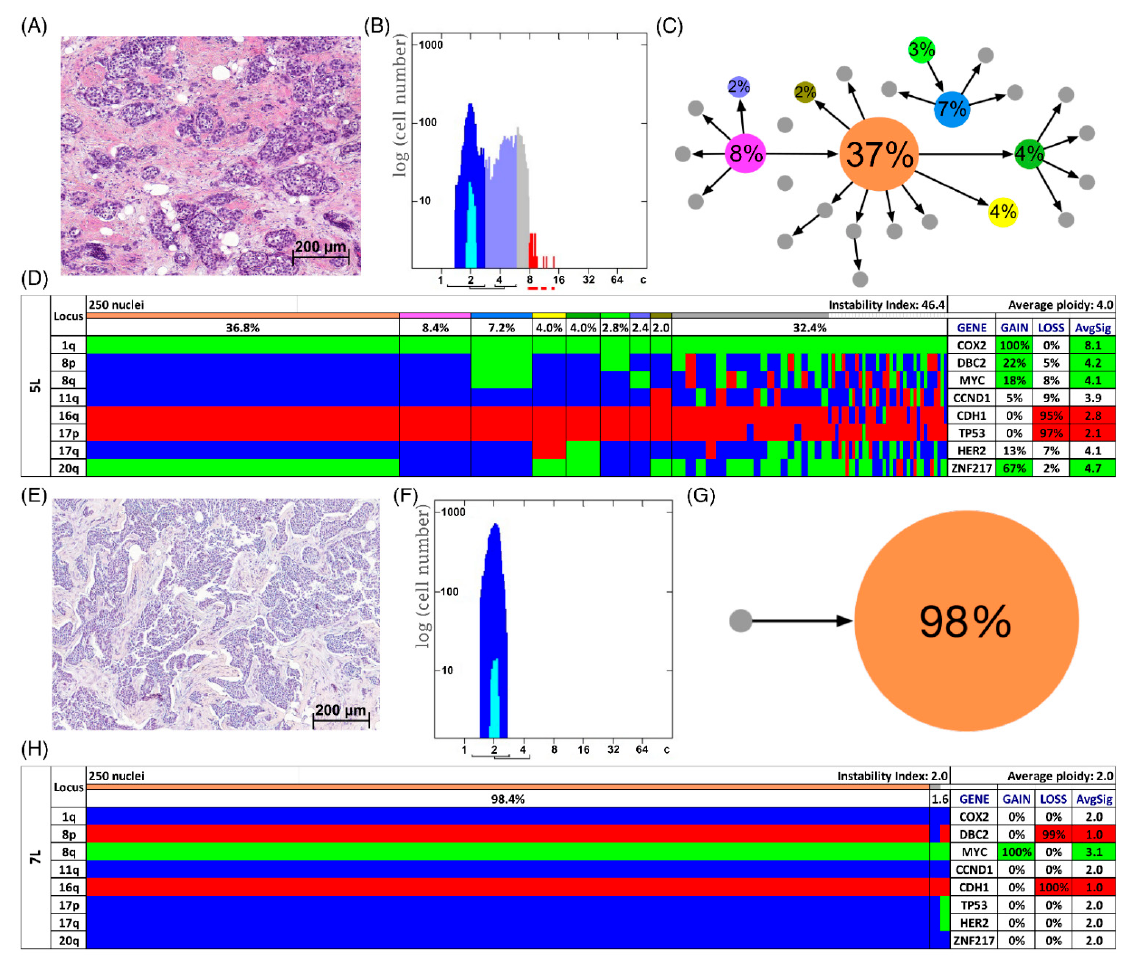
Figure 3. Patients with long survival. Histology ( A , E ), image cytometry ( B , F ), imbalance clone plots ( C , G ) and miFISH results ( D , H ) for the cases 5L ( A – D ) and 7L ( E – H ). ( A , E ) Sections of the respective breast cancer samples showing the histomorphology based on H&E staining. ( B , F ) DNA histograms showing the quantitative measurements of the nuclear DNA content assessed by image cytometry using Feulgen-stained cytospins. The DNA measurements revealed aneuploidy in case 5L and diploidy in case 7L. For quantitative measurement of the DNA content the sample was screened for several diploid nuclei (granulocytes, lymphocytes) to set the 2c value indicating a diploid DNA content. The quantitative measurements of the nuclear DNA content (x axis) of the tumor cells given in ‘c’ units were then calculated accordingly [18]. The y axis represents the total cell count. In case 5L 4759 and in case 7L 11,792 nuclei were analyzed. ( C , G ) Imbalance clone plots visualizing the clonal composition of the analyzed breast cancer section and their putative evolutionary trajectory. The area of the circles correlates with the occurrence of a cell-clone with a specific gain-and-loss pattern within the tumor cell population. Clones derived by a single gain or loss change are connected by arrows. The arrows indicate the clonal evolution according to gain-and-loss patterns in the color charts ( D , H ) starting from the clone with the fewest gains and losses. Thus, unconnected clones must differ in more than one gain or loss in their gain-and-loss pattern. Color coding allows assignment of the individual clones to the corresponding clones in the color charts in D and H. ( D , H ) Color chart of miFISH analysis with 8 gene-specific probes. Copy number counts for each nucleus are displayed as gains (green), losses (red) and neutral (blue). Markers are plotted vertically with the ‘Locus’ column depicting the specific chromosome arm for each probe on the left of the plot, and the corresponding gene name on the right. Nuclei are plotted horizontally by pattern frequency. Each vertical line discerns specific gain-and-loss patterns and the prevalence of the cell clone in the tumor population. Copy number gains and losses are depicted as percentages of the total cell population in the ‘Gain’ and ‘Loss’ column of the table on the right. Color-labeled percentages indicate a threshold of 15%. The column ‘AvgSig’ refers to the average of all signal numbers specified for each of the 8 analyzed gene probes.